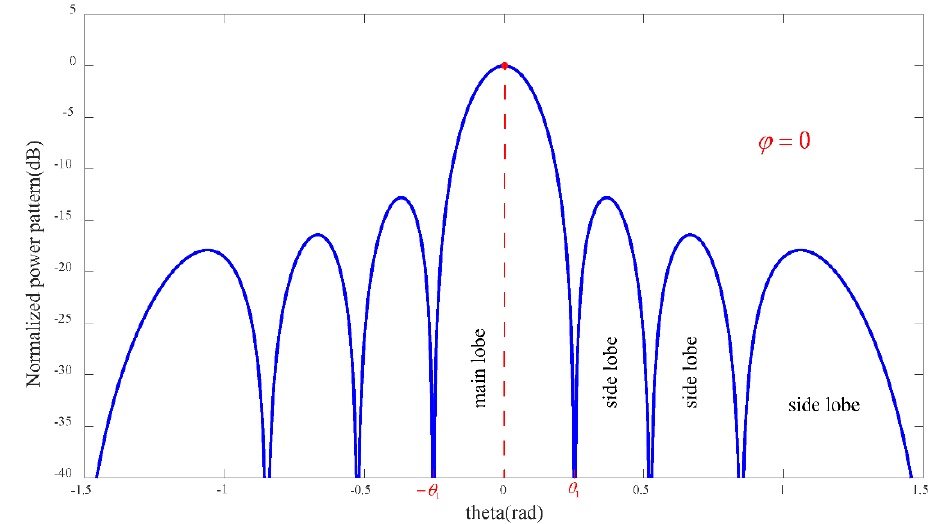
Figure 5. The power pattern in the E plane ( ϕ = 0) of the 8 × 8 subarray.